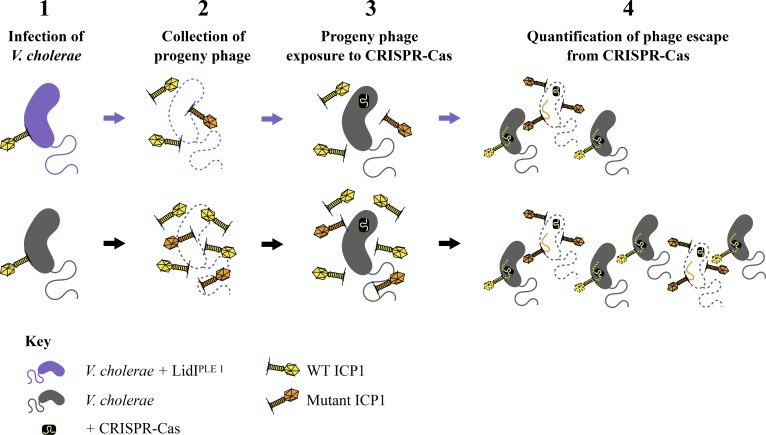
Diversity of progeny phage from infections as measured by phage escape from CRISPR-Cas – expanded schematic.1. V. cholerae strains with and without LidIPLE 1 (top/purple and bottom/grey, respectively) were exposed to ICP1 (yellow). 2. 90 minutes post-infection, infected cultures were mechanically lysed to release progeny phage (yellow and orange phage). 3. These progeny phage were plated on V. cholerae encoding a Type I-E CRISPR-Cas system (black rectangle) with a spacer against ICP1 (white and yellow line). 4. Only progeny phage that had mutated (orange) to escape targeting by the spacer could successfully infect, avoid degradation, replicate, and lyse cells to form plaques. Quantifying these plaques gives insight into how many mutant phage resulted from the initial infection.